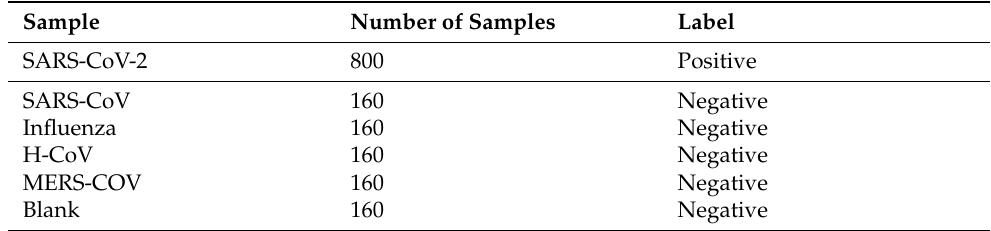
Table 2. The dataset used in machine learning to diagnose SARS-CoV-2.